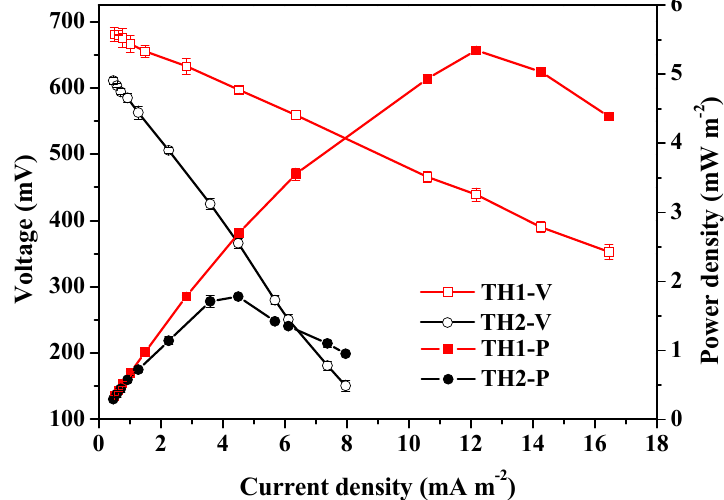
Figure 2. Polarization and power curves for SMFCs produced with TH1 and TH2 sediments on Day 450. Error bars were represented as mean values (n = 2).